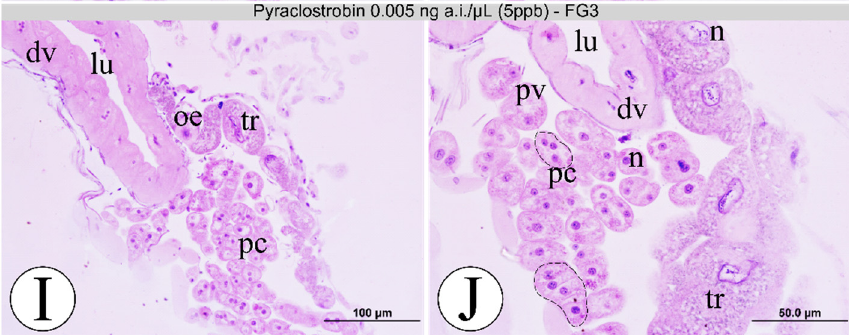
Figure 4. Pericardial cells of foragers of Africanized honey bee after five days of oral exposure to fungicide pyraclostrobin. ( A , B ): control-CTL; ( C , D ): acetone control-CAC; ( E , F ): pyraclostrobin 0.125 ng/µL (125 ppb)-FG1; ( G , H ): pyraclostrobin 0.025 ng/µL (25 ppb)-FG2; ( I , J ): pyraclostrobin 0.005 ng/µL (5 ppb)-FG3. Legend : asterisk = large central vacuole, black arrow = peripheral nucleus, dotted line = cordonal pericardial cells, dv = dorsal vessel, he = hemocytes, lu = lumen, n = nuclei, oe = oenocytes, pc = pericardial cells, pn = pyknotic nucleus, pv = peripheral vacuoles, tr = trophocytes. Histological sections stained with hematoxylin and eosin. N = 5 individuals per experimental group.